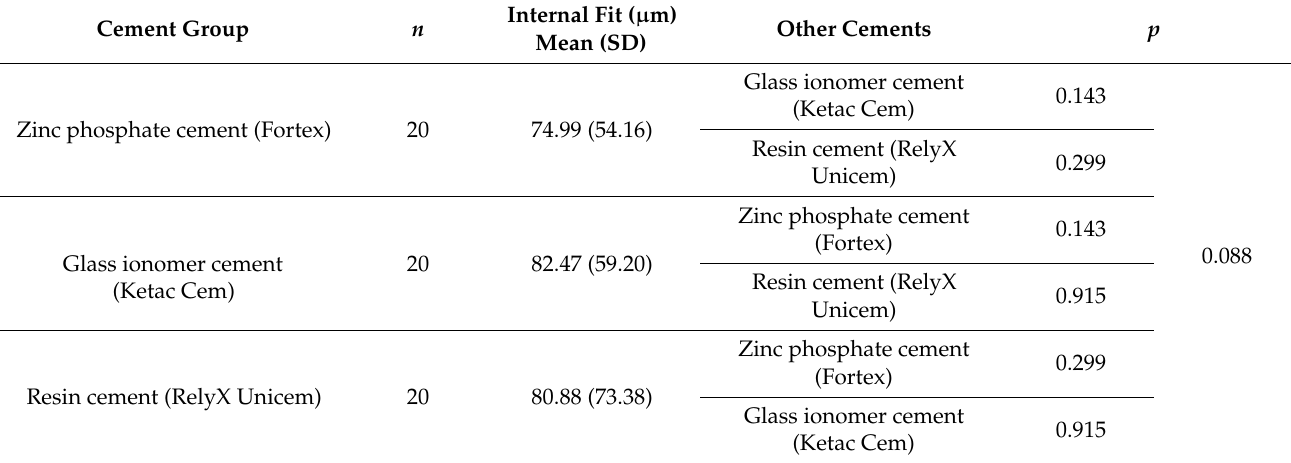
Table 1. Internal fit according to the type of cement used. SD: standard deviation.